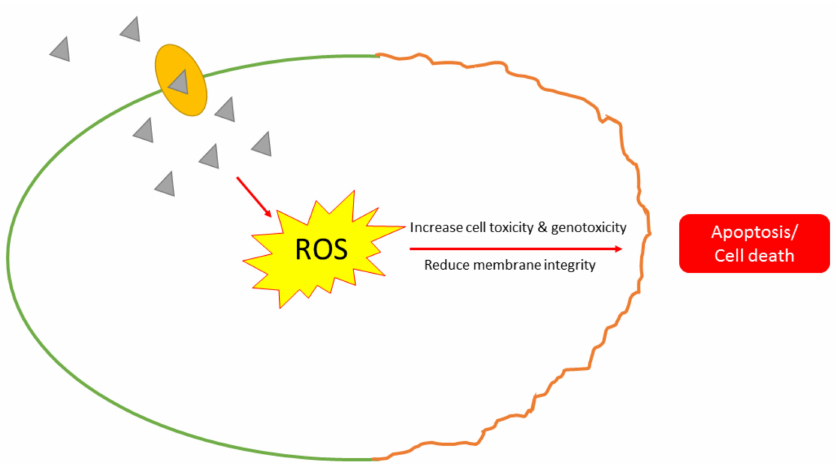
Figure 5. The mechanism of action of AgNPs affected through the formation of reactive oxygen species